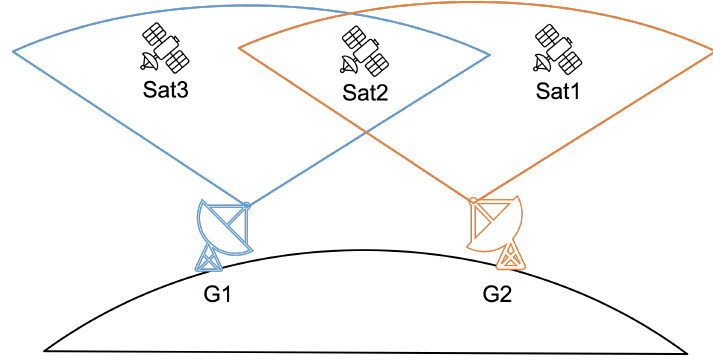
Figure 1. Example of MGSS problem.